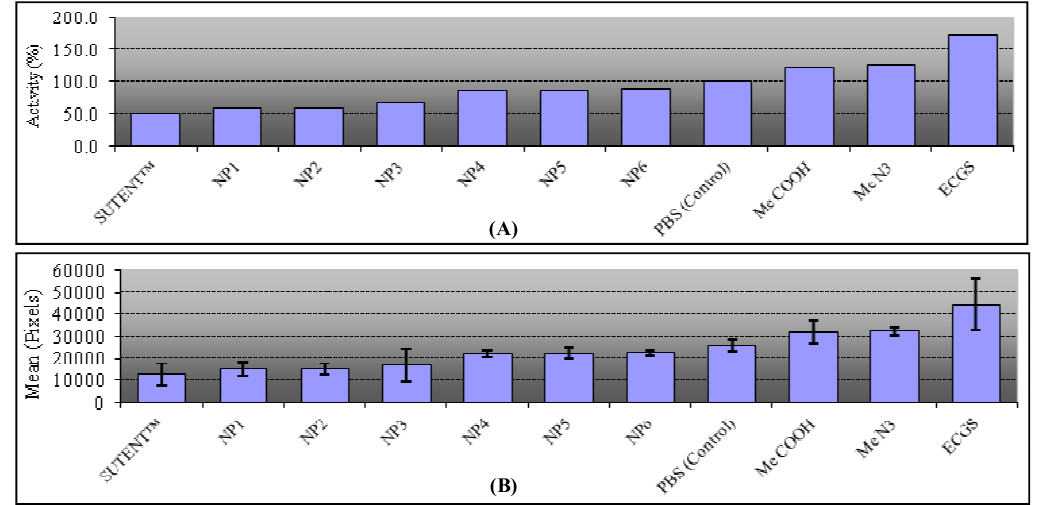
Figure 2. ( A ) CAM activity in percentage compared to PBS (control); ( B ) CAM activity in pixels (Image J) compared to PBS